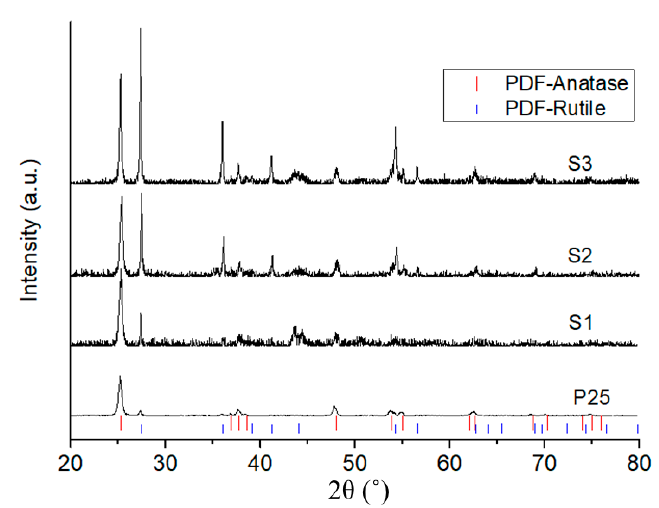
Figure 5. X-ray di ff raction (XRD) analysis of suspension HVOF TiO 2 Figure 5. X-ray diffraction (XRD) analysis of suspension HVOF TiO 2 coatings.